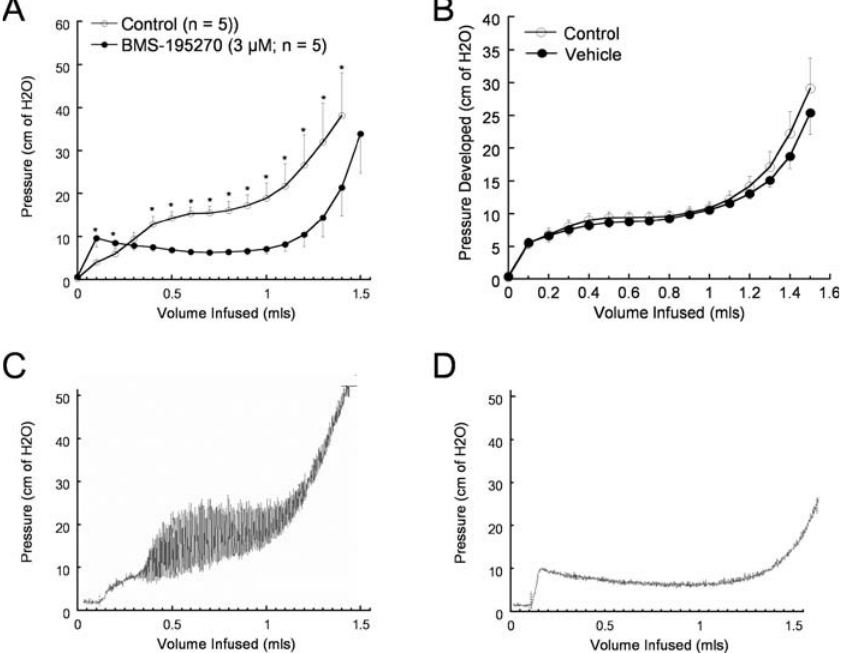
Figure 2. Effect of BMS Small Molecules in Ex Vivo Whole-Bladder Assays Bladder pressure was monitored during saline infusion in the presence of BMS-195270 or vehicle. A typical cystometric curve shows three phases: a small rapid rise in intravesical pressure followed by a plateau phase and then a final sharp increase in pressure. (A) Bladder pressure following treatment with BMS-195270 (3 l M; n ¼ 5 bladders). The average pressure at discrete infusion volumes is shown. Significant differences in pressure relative to control ( p , 0.05) are indicated by asterisks. (B) Bladder pressure following treatment with vehicle ( n ¼ 12 bladders). The average pressure at discrete infusion volumes is shown. No difference in pressure relative to control was seen. (C) Representative trace from vehicle-treated bladder, showing magnitude of spontaneous contractions developed during saline infusion. (D) Representative trace from bladder treated with BMS-195270 (3 l M), showing reduction in frequency and magnitude of spontaneous contractions developed during saline infusion. DOI: